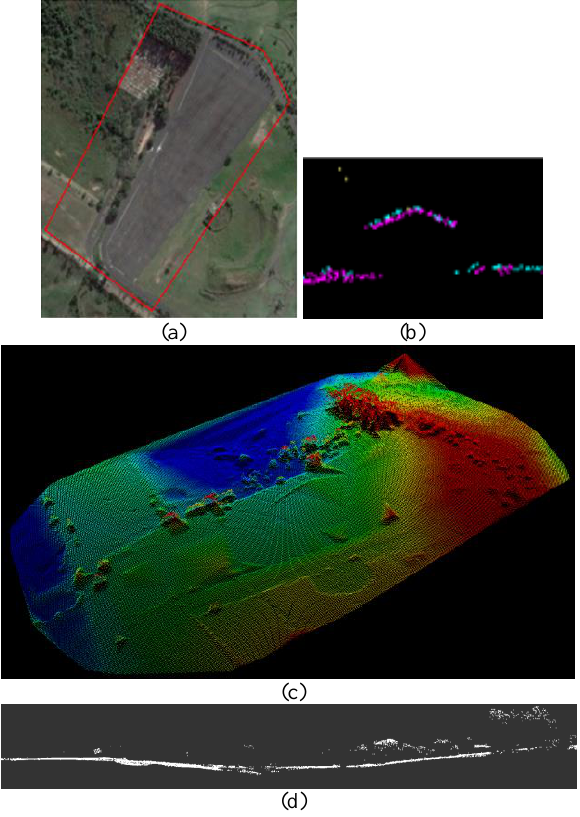
Figure 2. (a) Area covered; (b) point cloud profile sample containing a building; (c) MDS from the resulting point cloud (d) Sample point cloud generated from the scanning device data of one single Figure 1. Main components of the light-weight laser scanner system (a) laser scanner; (b) INS; (c) Raspberry PI; (d) UAV octopter.